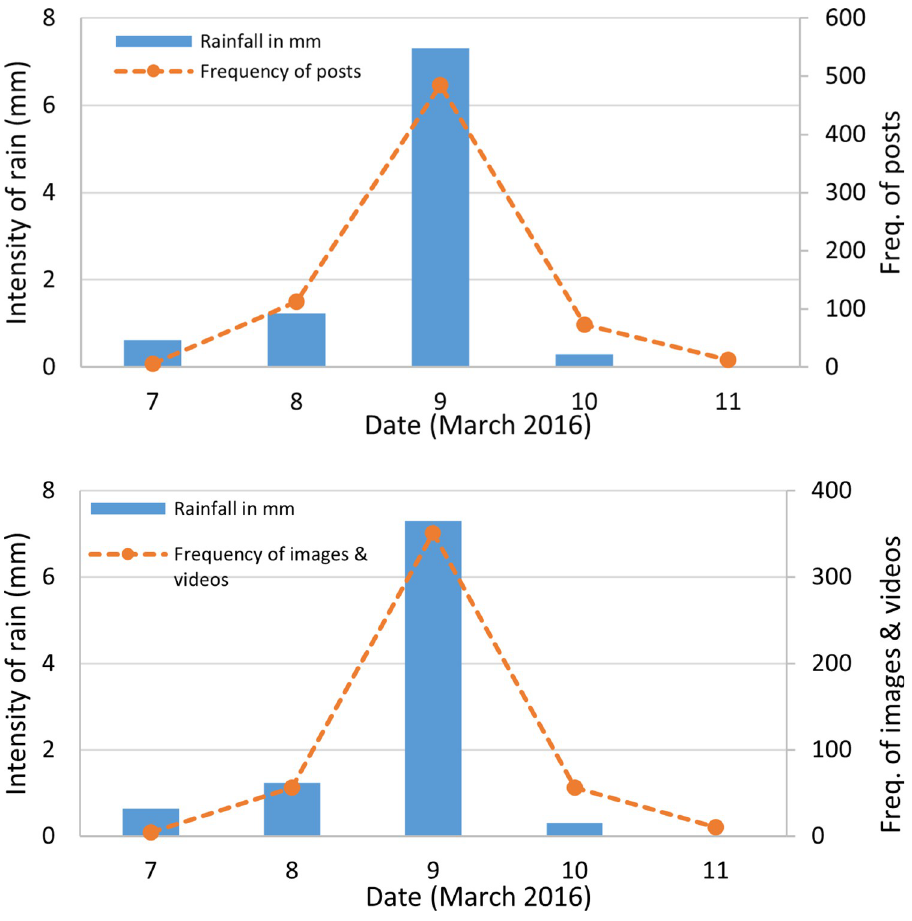
Fig 6. Time series of rainfall depths (a) with frequency of total posts per day, (b) with frequency of images and videos per